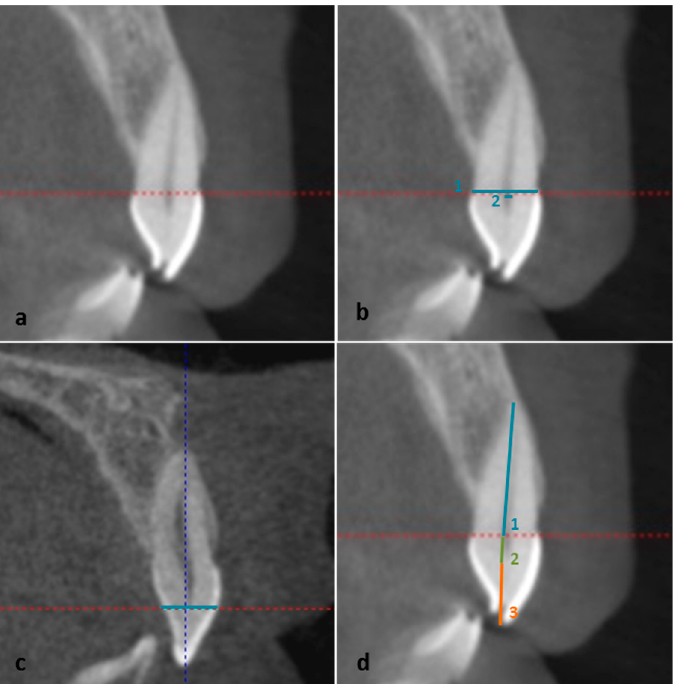
Figure 1. ( a ) Incisor in neutral position; ( b ) sagittal measurements at cementoenamel junction: (1) sagittal tooth width (sce_TW), (2) pulp width (sce_PW); ( c ) sagittal measurement at pulp horn: in- cisor crown width (sph_CW); and ( d ) sagittal vertical measurements: (1) root length: (s_RL), (2) pulp chamber length (s_PCL) and (3) incisal length: (s_IL).